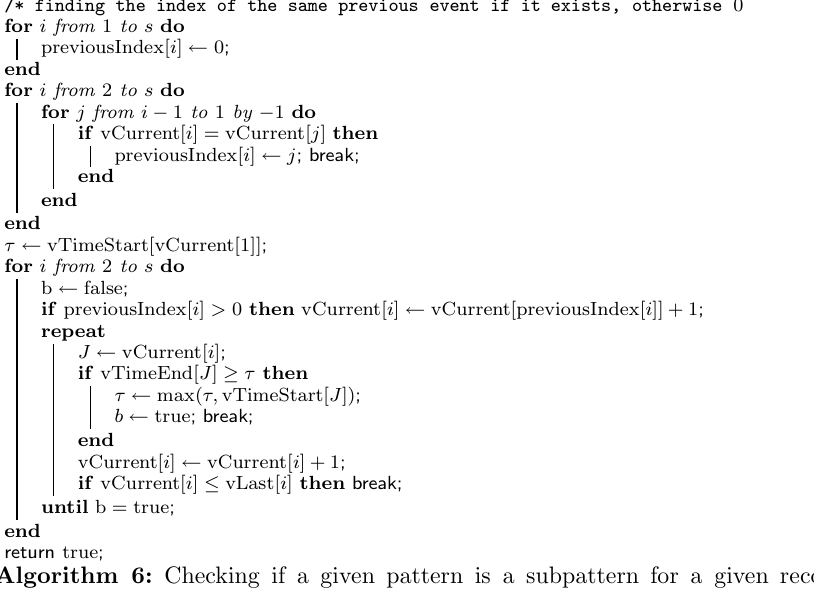
Algorithm 6: Checking if a given pattern is a subpattern for a given record (iteration step) for ordered